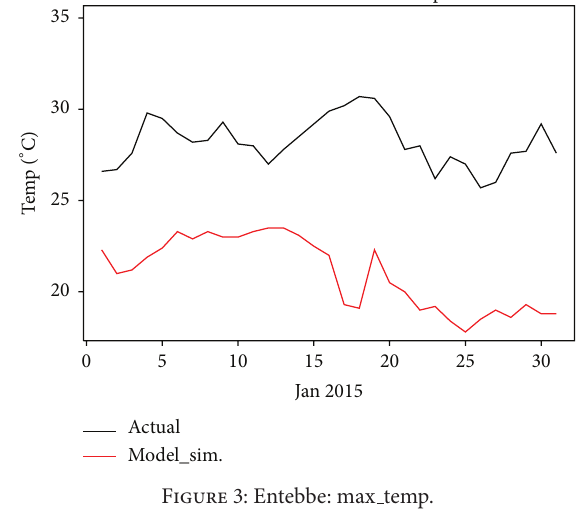
Figure 3: Entebbe: max temp.